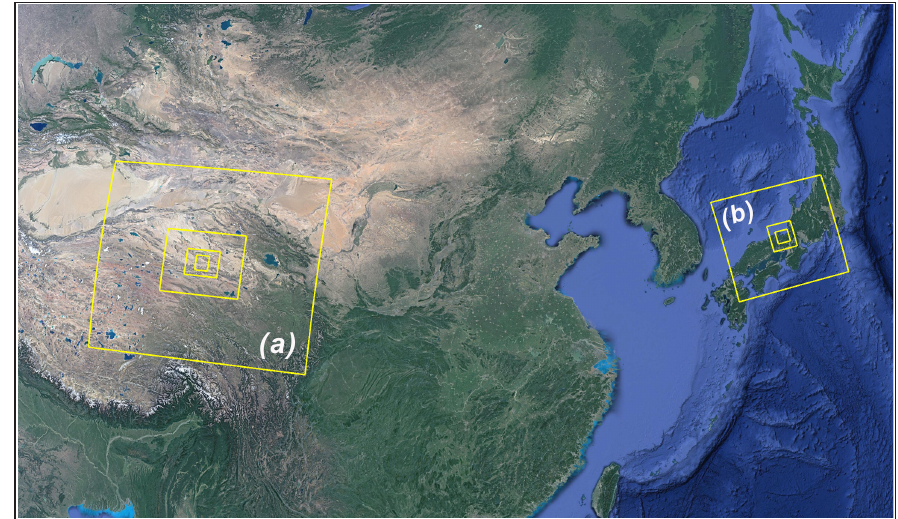
Figure 3. Domain configurations of the WRF (Weather Research and Forecasting) model for Qinghai ( a ) and Maizuru ( b ) sites in Japan and China, respectively. This image is taken from Google